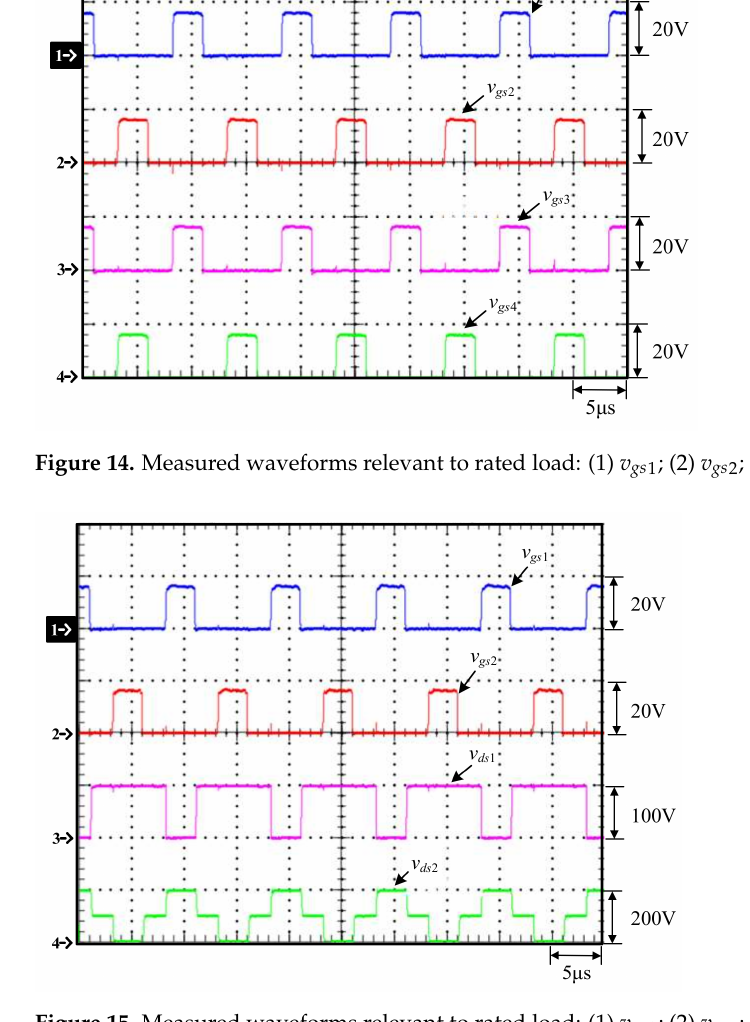
Figure 15. Measured waveforms relevant to rated load: (1) v gs 1 ; (2) v gs 2 ; (3) v ds 1 ; (4) v ds 2